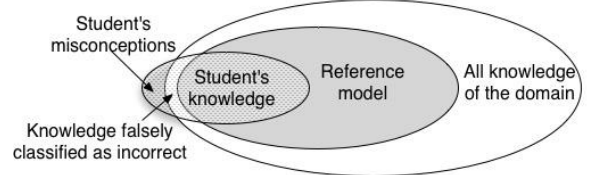
Fig. 1. The relationship between student’s knowledge, reference model and all correct knowledge of the